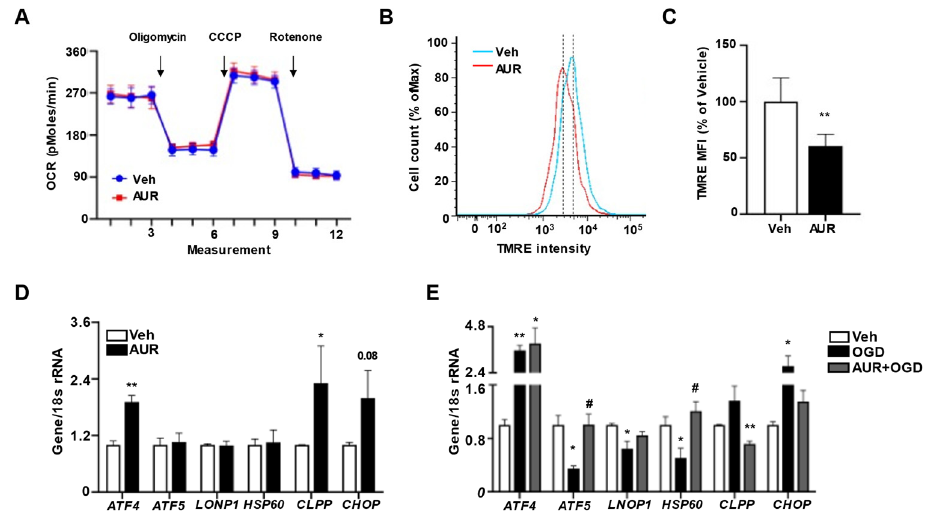
Figure 3. Loss of mitochondrial membrane potential accompanying induction of mtUPR in bEnd.3 cells by AUR treatment. ( A ) Oxygen consumption rate (OCR) was measured in bEnd.3 cells treated with vehicle or 1 µ M AUR for 24 h. ( B ) bEnd.3 cells were incubated with vehicle or 1 µ M AUR. The cells were stained with 100 nM TMRE and analyzed by flow cytometry. ( C ) Mitochondrial membrane potential was determined by TMRE-stained cells. The Median fluorescence intensity (MFI) values are analyzed by FlowJo program. ( D ) Expression of mRNA for mitochondrial unfolded protein response (mtUPR) genes was examined after 1 µ M AUR treatment using qPCR. ( E ) Expression of mRNA for mitochondrial unfolded protein response (mtUPR) genes was examined with bEnd.3 cells incubated in oxygen-glucose deprivation (OGD) condition for 3 h after pretreated vehicle or 1 µ M AUR 24 h. Data are presented as mean and ± SEM of three independent experiments (* p < 0.05, ** p < 0.01, *** p < 0.001 compared to Veh, # p < 0.05 compared to OGD).